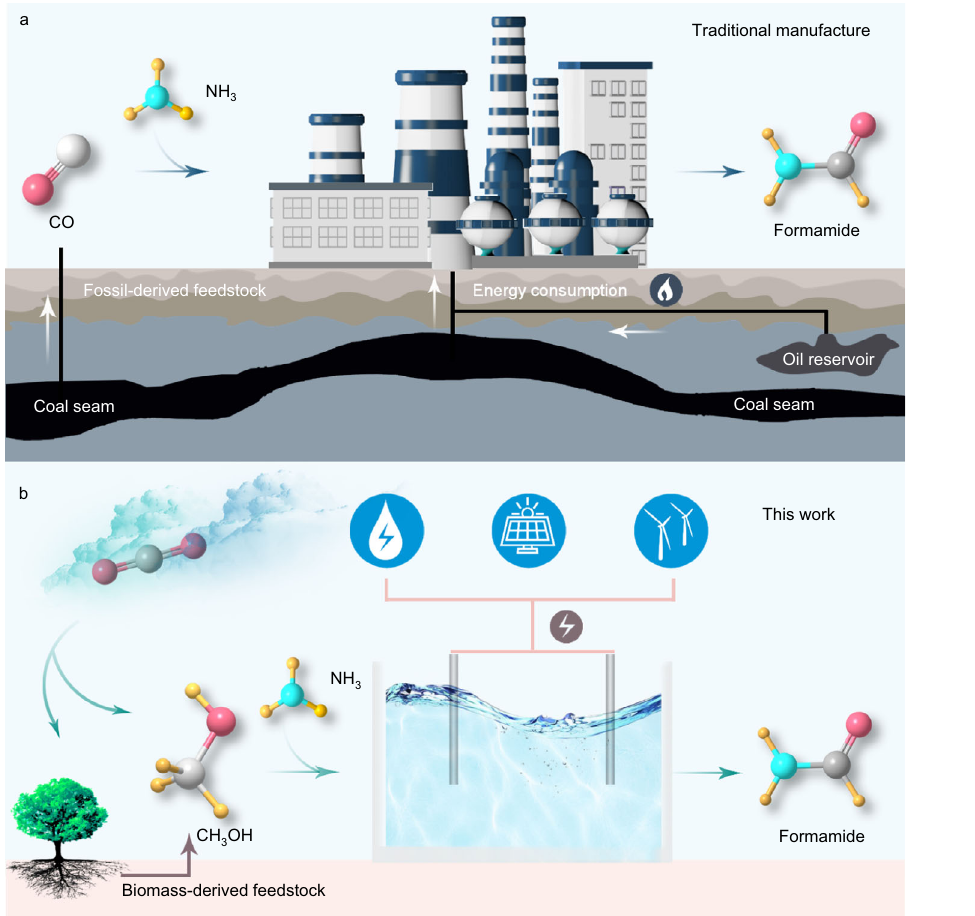
Fig. 1 | The manufacturing approaches of formamide by the industrial thermochemical system ( a ) and the proposed electrochemical system ( b